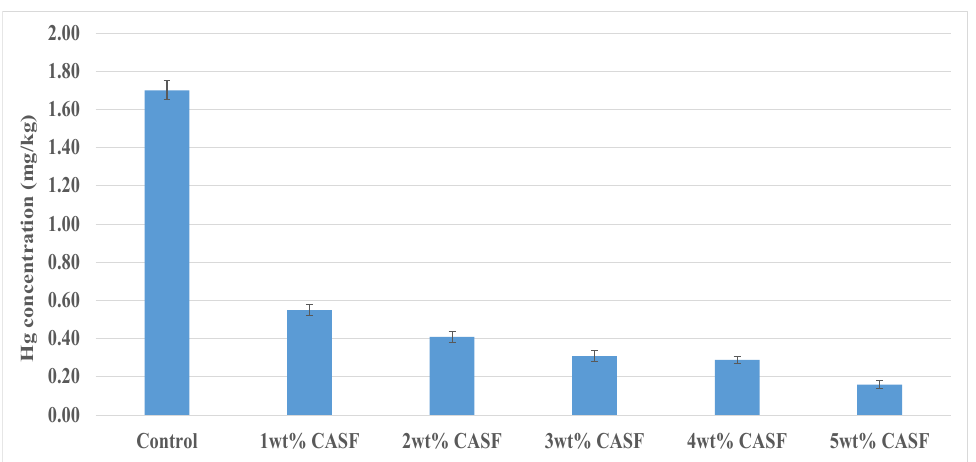
Figure 6. Hg leachability of the control and PSF (-#10 mesh) treated samples after 28d of curing, upon 1N HCl extraction.